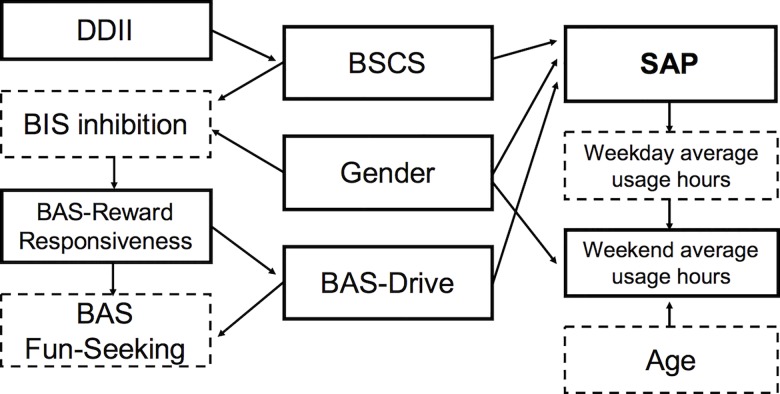
Bayesian belief network for SAP and variables.Arrows are directed from cause to result. Solid boxes = Variables with p-value < 0.01, Dashed boxes = Variables with p-value ≥ 0.01 in logistic regression.